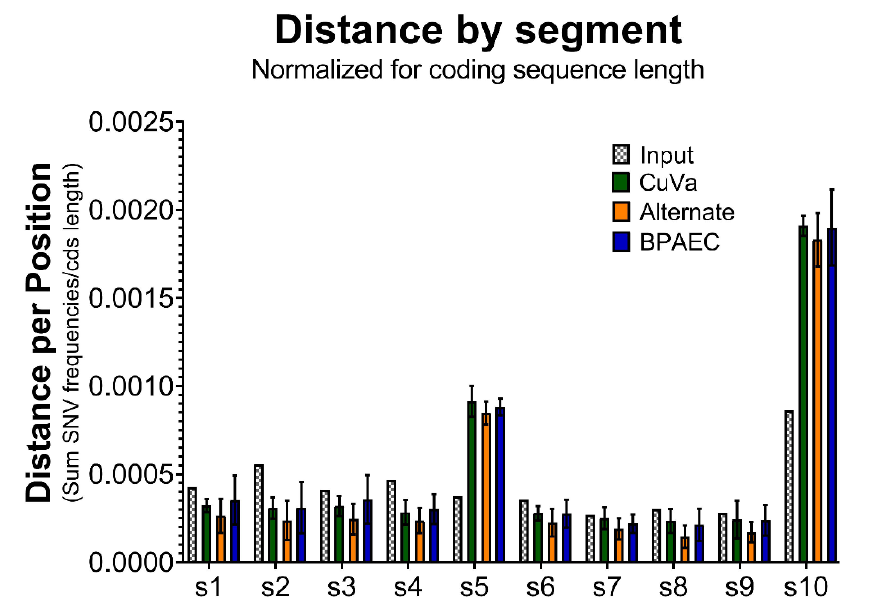
Figure 2. BTV Genetic Distance by Segment across Cell Culture Conditions. Genetic distances (the sum of single nucleotide variant (SNV) frequencies per segment) were normalized by each segments’ coding sequence length. Segments 1–10 are represented along the x -axis (s1, s2, s3, s4, s5, s6, s7, s8, s9, and s10). For BTV17-CUVA, -ALT, and -BPAEC, mean distance (and standard deviation) for each segment across passages 3, 6, and 9 is shown.